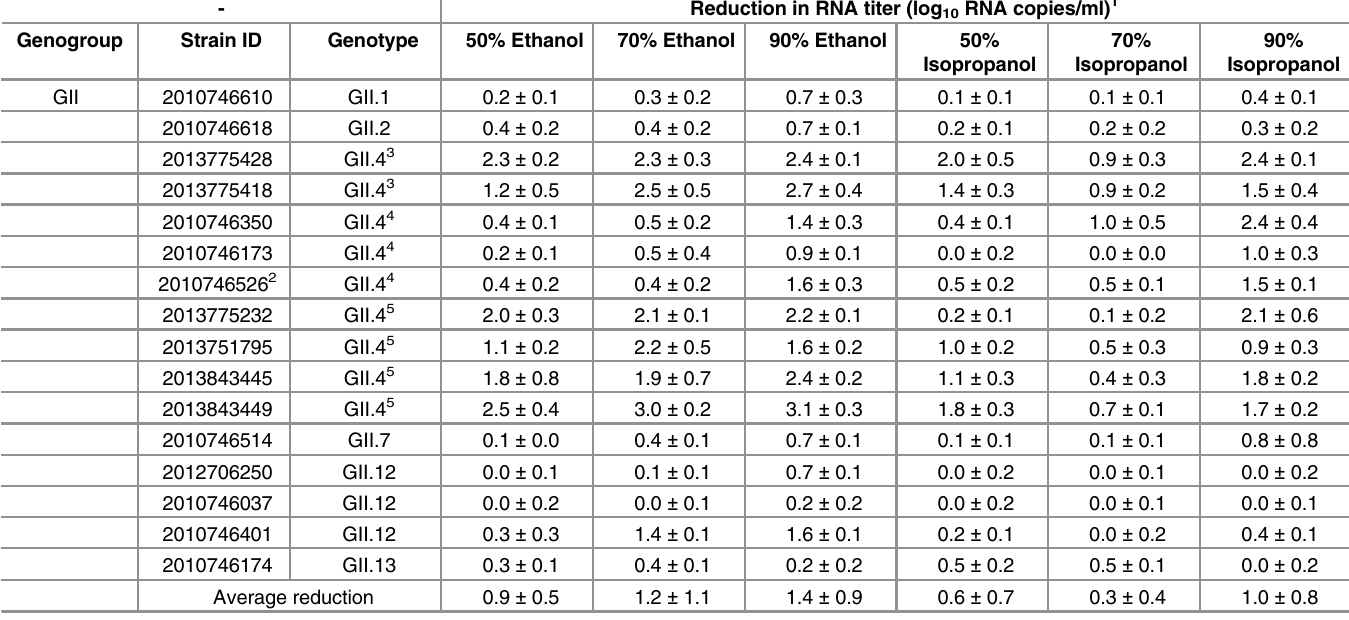
Table 2. Virolysis patterns of GII norovirus strains after exposure to ethanol and isopropanol. -